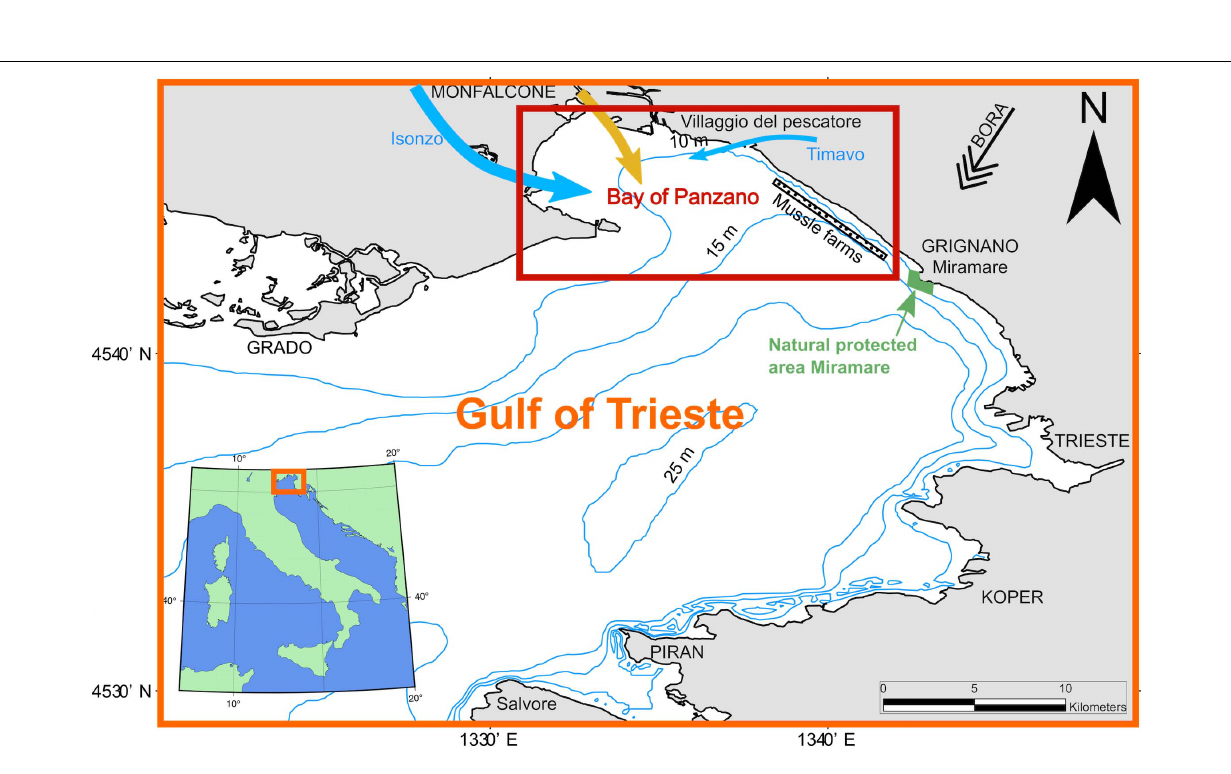
Frontiers in Marine Science |